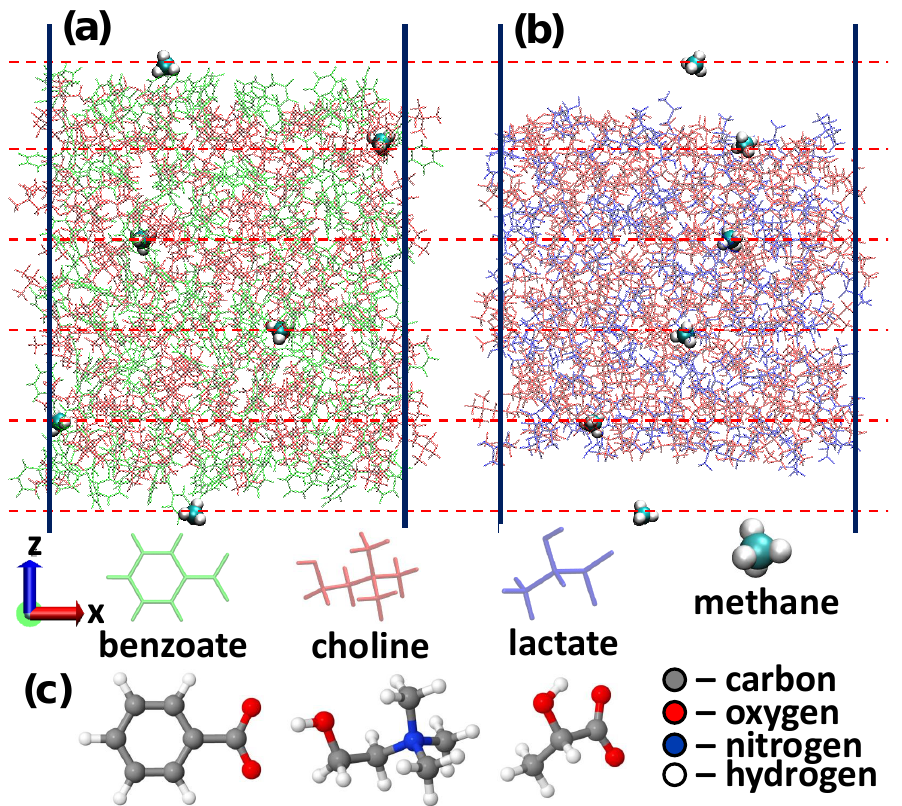
Figure 1. ( a , b ) Slabs of choline-benzoate ( a ) and choline-lactate ( b ) ionic liquids with embedded CH 4 molecules. ( c ) Optimized structures of benzoate, choline and lactate